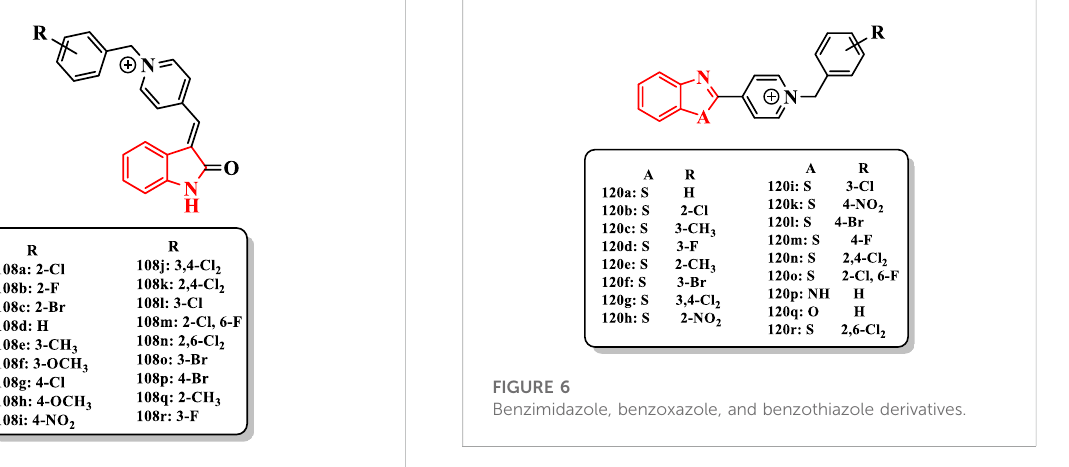
FIGURE 5 Indolinone-based compounds.